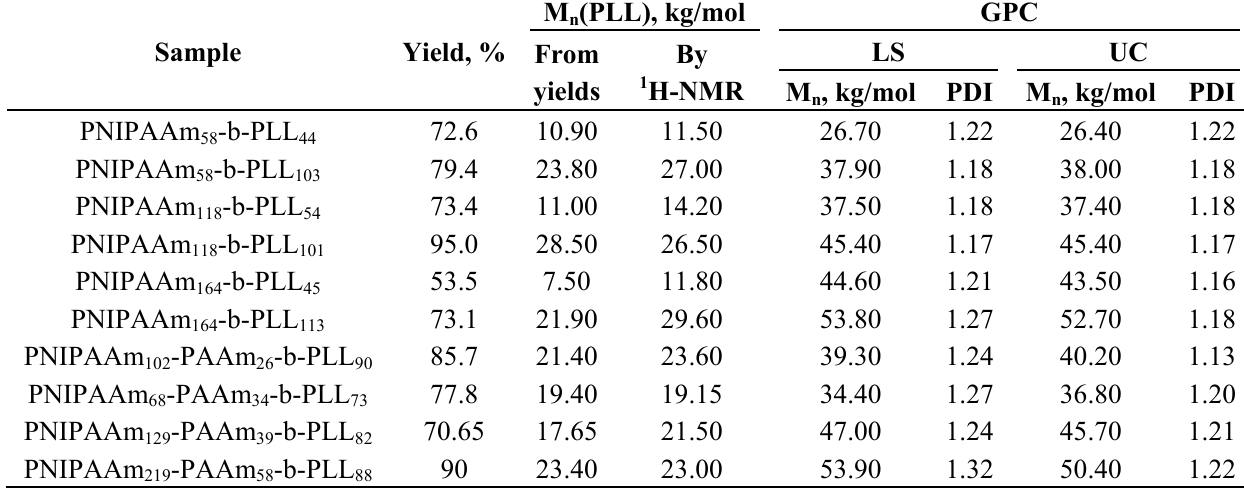
Table 3. Diblock copolymers of PNIPAAm/PNIPAAm-PAAm and PLL were characterized by GPC and 1 H-NMR. M well as from 1 H-NMR. Sample Yield, %